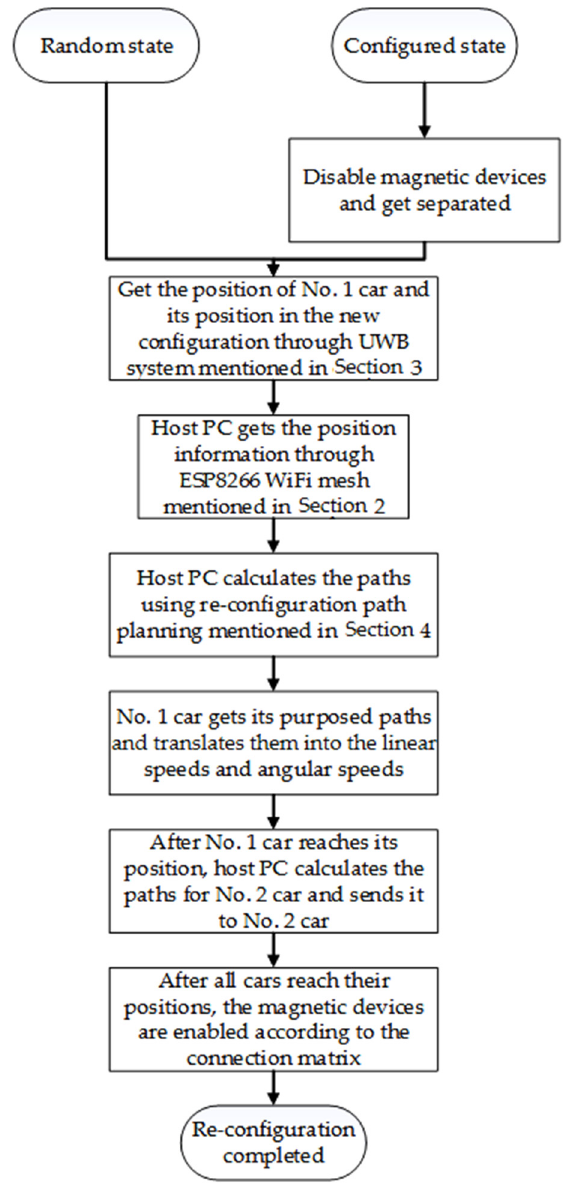
Figure 13. Algorithm and implementation .